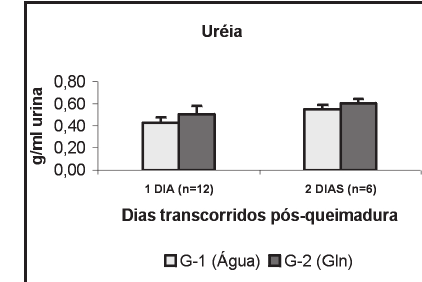
FIGURA 3 – Representação gráfica da concen- tração de lactato na pele sadia e queimada dos animais dos grupos 1 e 2 nos dias 1 e 2 do estudo.